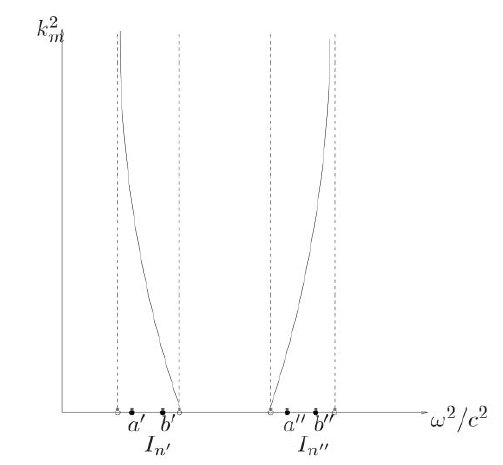
Figure 5. The leading order dispersion relation over two selected intervals I n (cid:48) and I n (cid:48)(cid:48) .